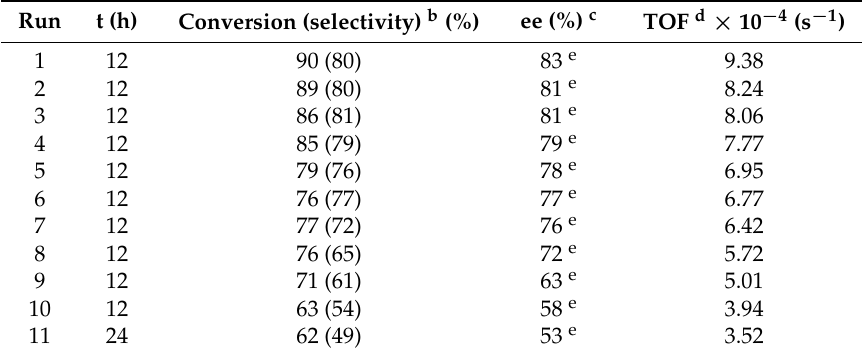
Table 4. Recycling data for enantioselectivity epoxidation of α -methylstyrene as representative substrate using catalyst 1 a